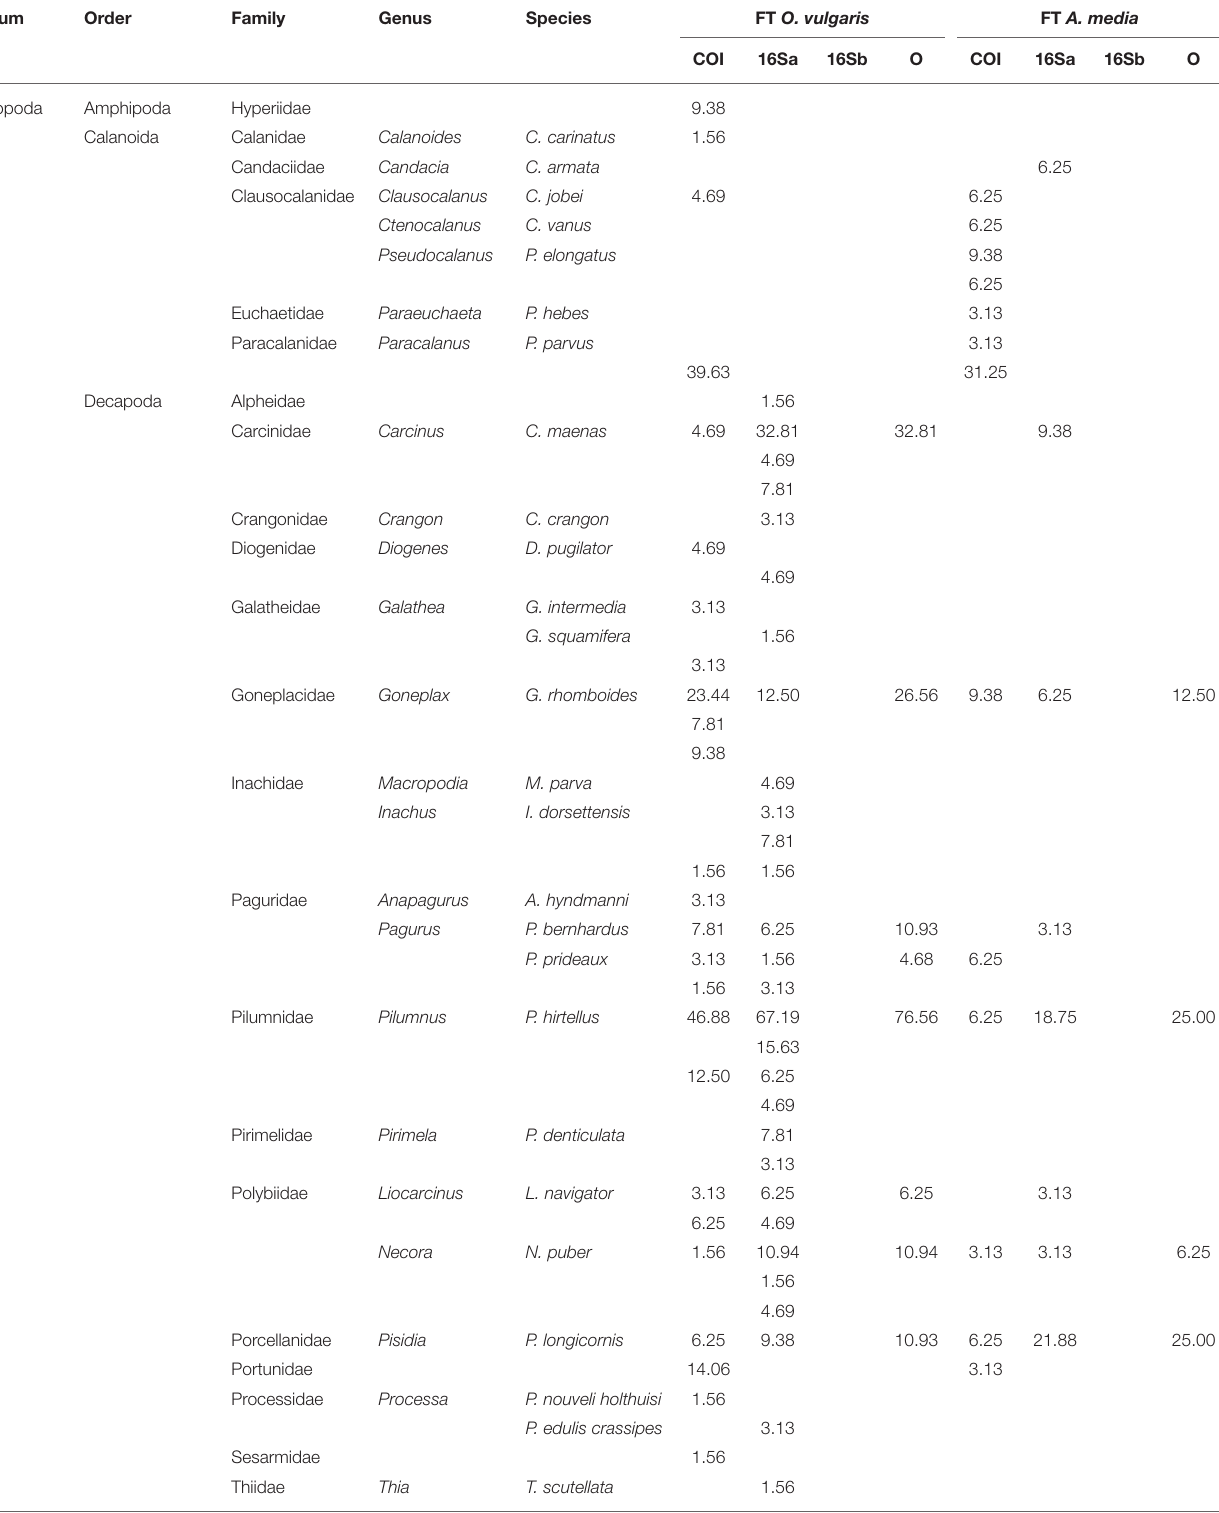
TABLE 2 | Taxonomic groups identified with the different primers (COI, 16Sa or16Sb) in both predators. Phyllum